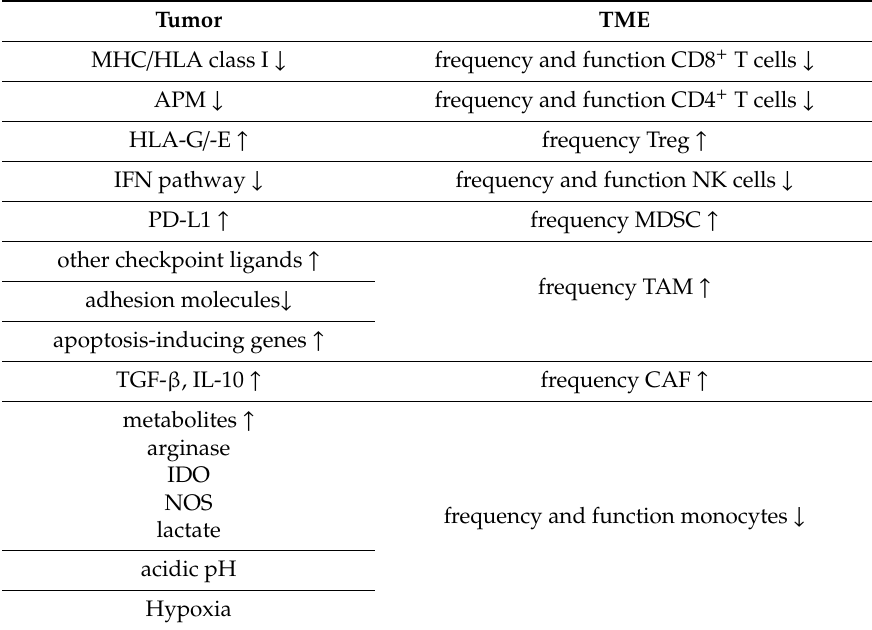
Table 2. Immune escape mechanisms of solid tumors.